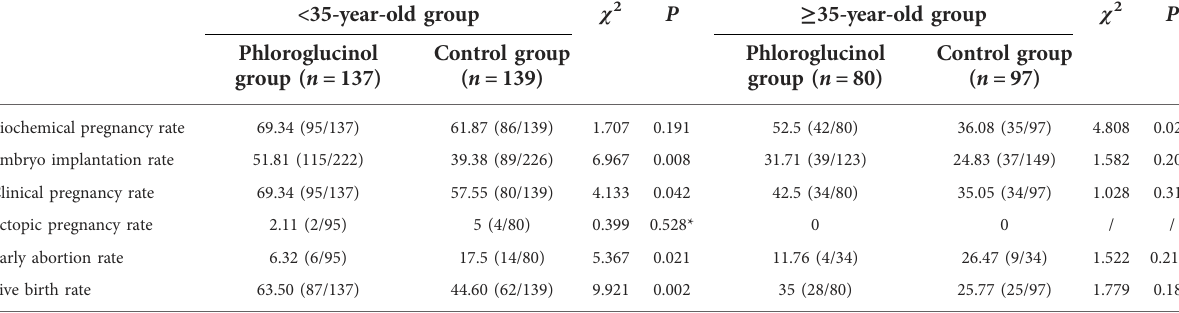
TABLE 4 Comparison of pregnancy outcomes of patients in different Age groups